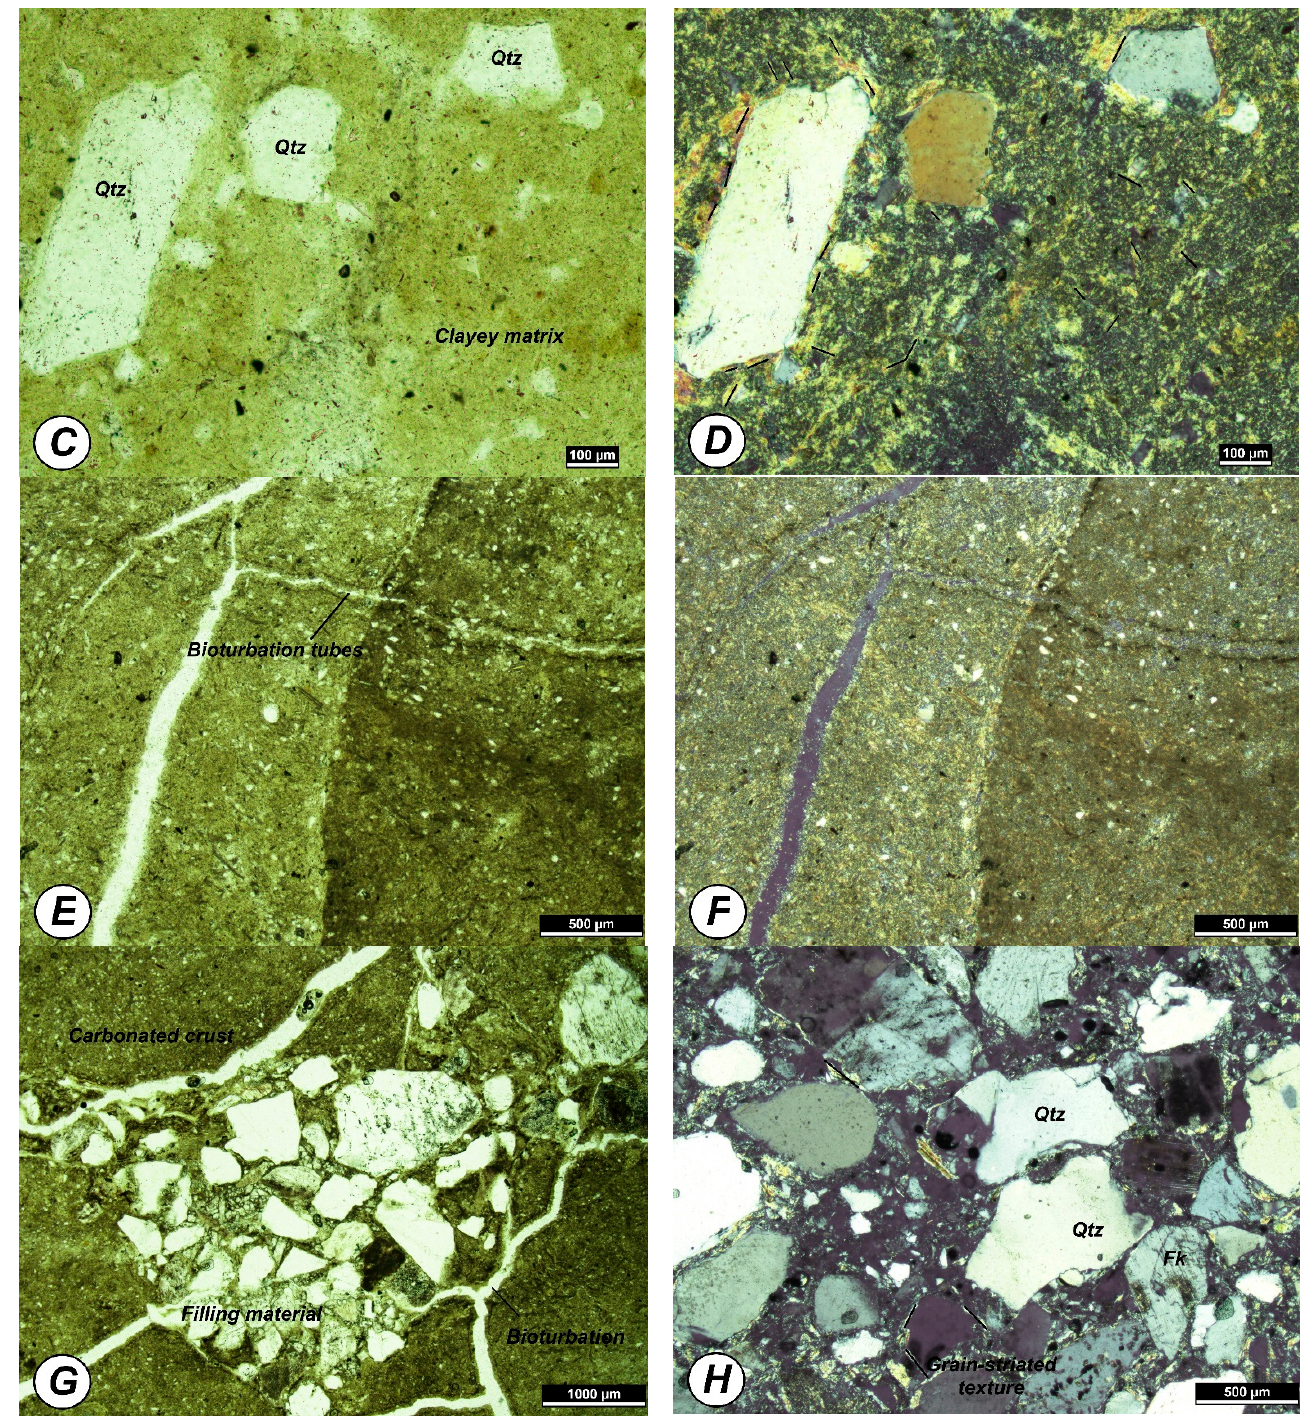
Figure 4. Microstructured features observed under petrographic microscopy. ( A ) Fine-grained laminated feldspathic arenite. In the upper central part of the image, there is a crusted area approximately 1 mm long (pelloid). ( B ) Carbonate nodulus in a feldesphatic arenite. ( C ) Sandy lutite with quartz grains in a reorganized clay matrix with an S-matrix microstructure (parallel polarized light, PPL). ( D ) Sandy lutite with quartz grains in a reorganized clay matrix with an S-matrix microstructure (crossed polarized light, CPL). ( E ) Sandy silicate clays with an incipient carbonate crust. The darker area corresponds to a more developed crust (NPL). ( F ) Sandy silicate clays with an incipient carbonate crust. The darker area corresponds to a more developed crust (CPL). ( G ) Burrow filled and surrounded by a carbonate crust (NPL). ( H ) Silicate sand with grain-striated or b-striated fabric, and around the clasts—quartz and feldspars, fundamentally—the arrangement of the clays as a border, evidence of paleo-edaphic processes (CPL).